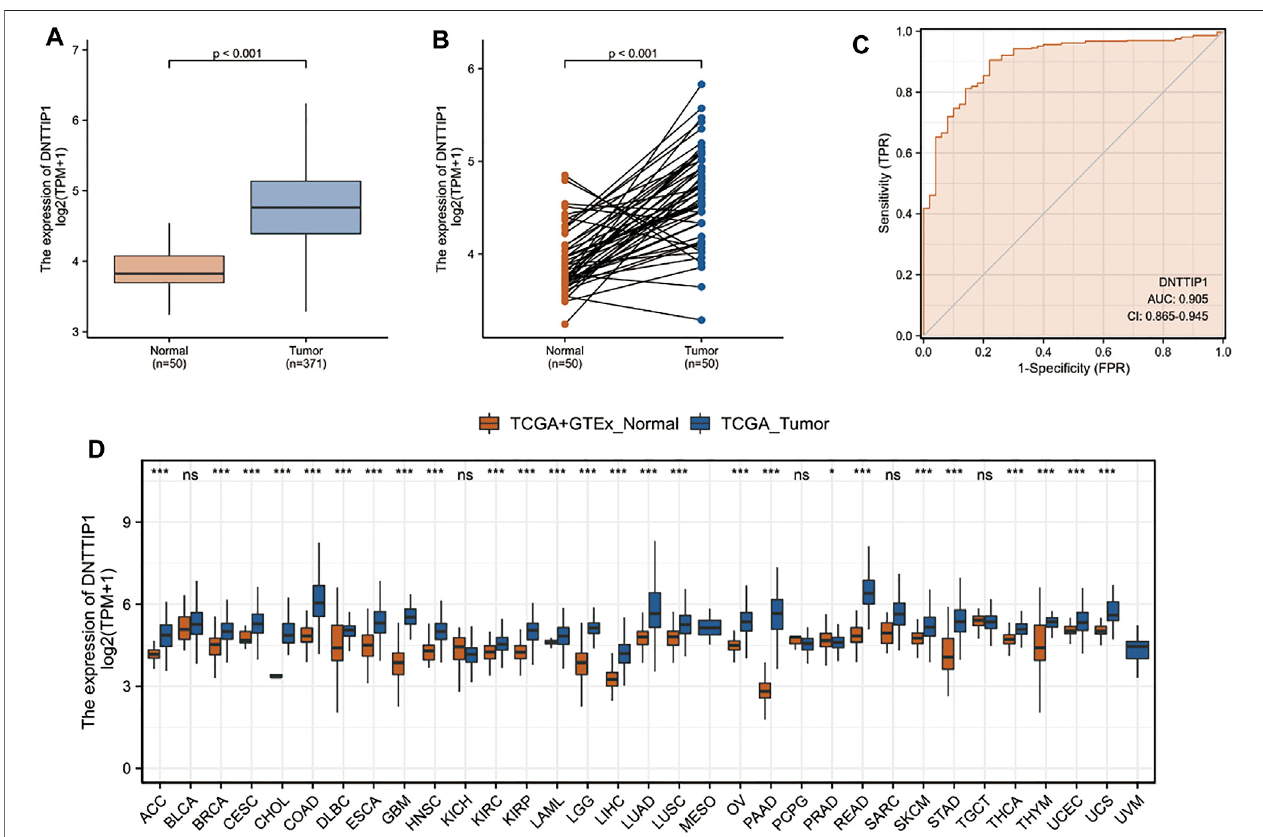
FIGURE5| Prognostic value of DNTTIP1 in LIHC and other cancer types. (A,B) DNTTIP1 is highly expressed in LIHC samples when compared with normal tissues. (C) ROC curve indicates that DNTTIP1 is a potential diagnostic marker. (D) DNTTIP1 is signi fi cantly overexpressed in other cancer types when compared with normal tissues. Data were processed TPM format RNA-seq data originated from TCGA and GTEx downloaded from UCSC XENA (https:// xenabrowser.net/datapages/).